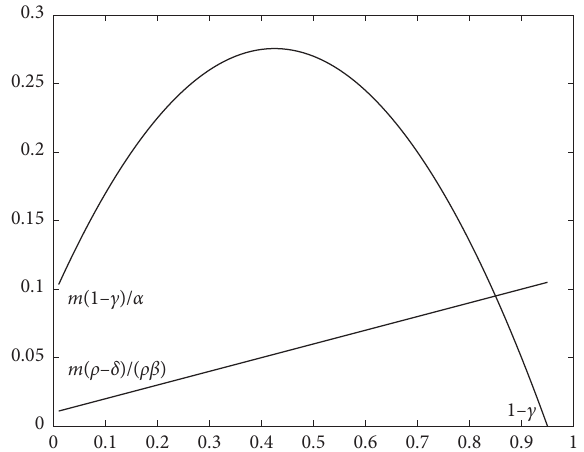
Figure 1: The position of each point in (13) with ρ � 0 . 1, α � 1,